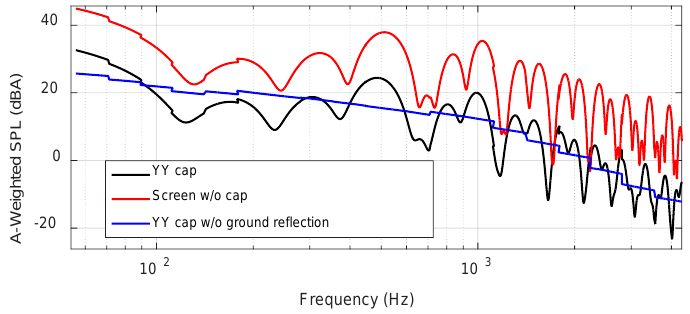
Figure 25. A-weighted SPL spectrum with 1 Hz resolution in Configuration 1 (Car–Person) for ‘YY’ cap with and without ground reflection. The screen barrier SPL spectrum is shown as a reference.